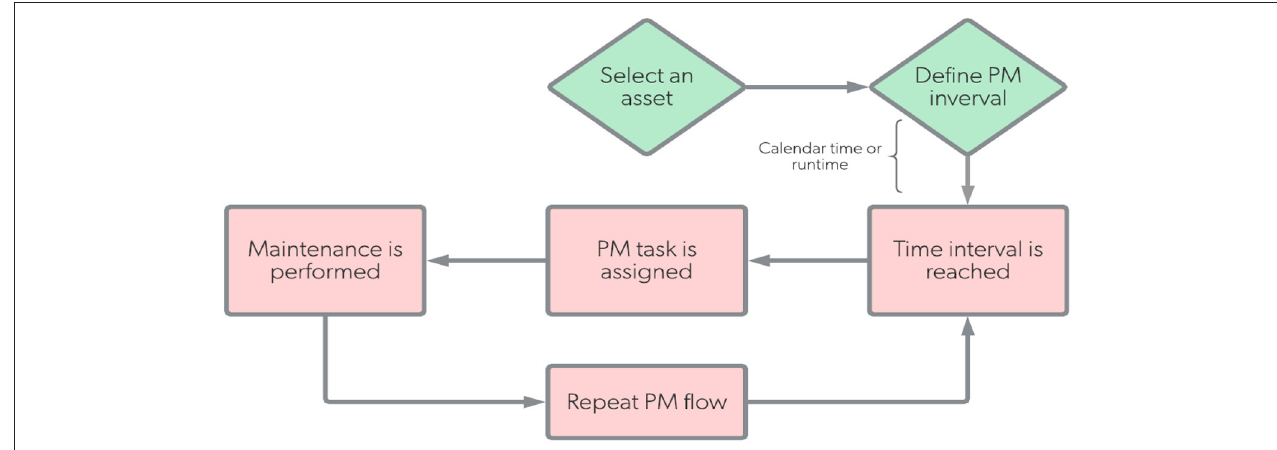
FIGURE 13 | Preventive maintenance workflow for our